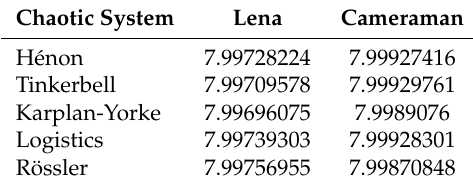
Table 3. Information entropy H ( s ) of the Lena and Cameraman